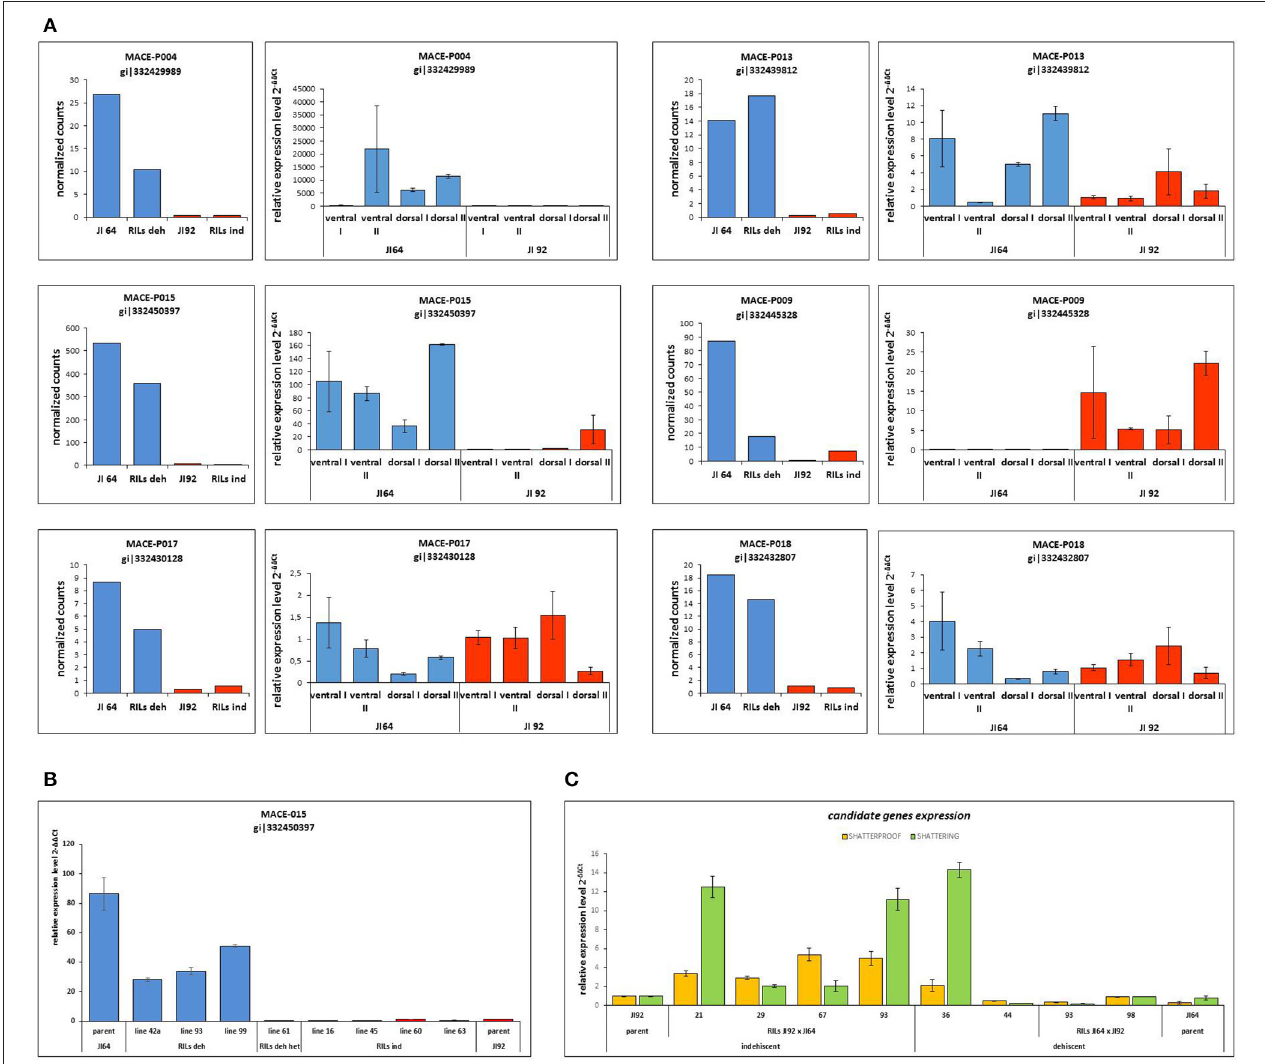
FIGURE 10 | qRT-PCR validation of selected DEGs detected to be associated with pod dehiscence. (A) MACE results in comparison with qRT-PCR of selected candidate genes. MACE-P004, MACE-P013, and MACE-P015 shows the same trend of over/down expression between MACE results of parental lines and RILs (JI 64—dehiscent pod, bulk of dehiscent RILs, JI 92—indehiscent pod, bulk of indehiscent RILs) and qRT-PCR of cDNA of parental lines (ventral or dorsal pod suture in two stages: I—younger stage, II—older stage). MACE-P009 showed the opposite results and MACE-P017 and MACE-P0018 without any trend of down